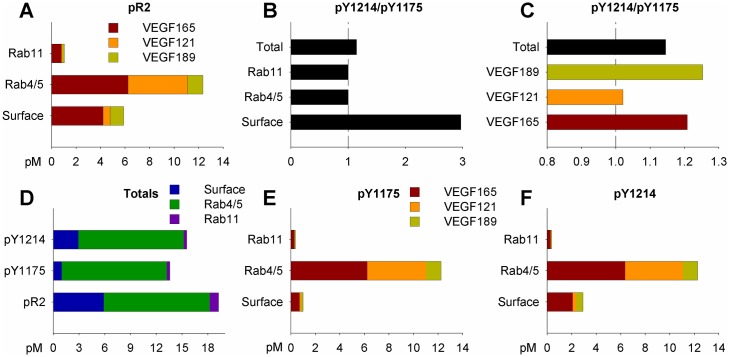
VEGF isoform-specific trafficking and site-specific phosphorylation of VEGFR2 in vivo.(A) VEGF isoform-specific NRP1-binding properties result in isoform-specific trafficking of VEGFR2. (B) Subcellular location-specific dephosphorylation rates for Y1175 and Y1214 (S9 Table) lead to preferential activation of tyrosine 1214 on the EC surface, compared to signaling in endosomes. (C) Isoform-specific trafficking and location-specific dephosphorylation combine to result in isoform-specific trends in relative activation of VEGFR2 on tyrosine 1175 and tyrosine 1214. (D) Total VEGFR2 phosphorylation, on at least one tyrosine (pR2) and specifically on Y1175 or Y1214, across all subcellular locations. (E-F) Distribution of pY1175 (E) and pY1214 (F), by VEGF isoform and location.